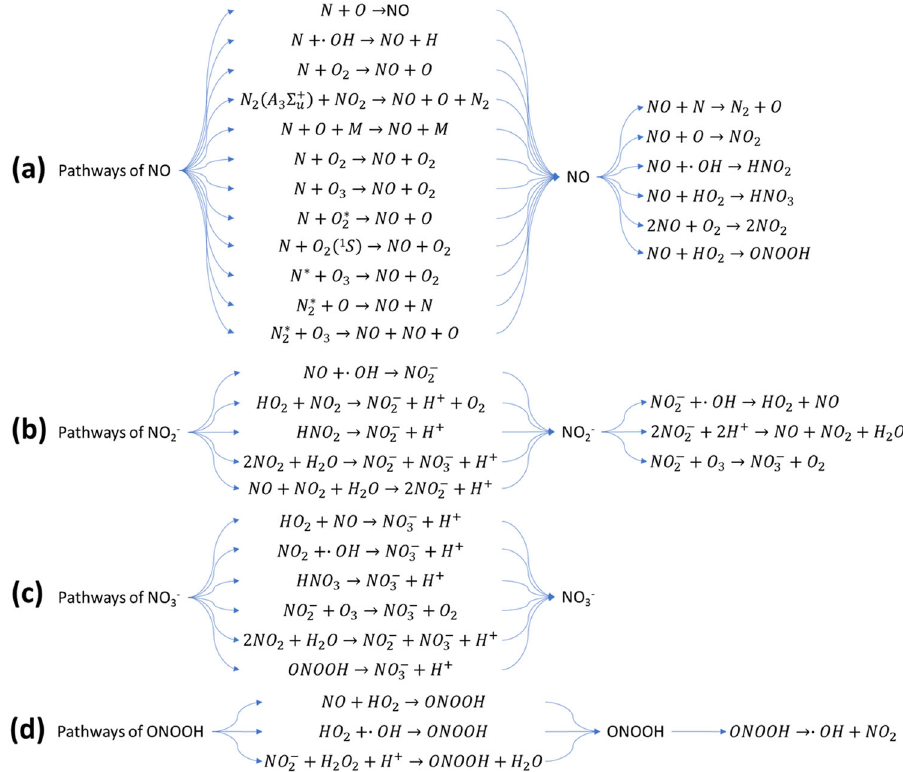
Fig. 5 Reactive nitrogen species (RNS) pathways. Pathways of: a NO, b NO 2 − , c NO 3 − , d ONOOH. Reactions show the possible formation and destruction of RNS in discharge with